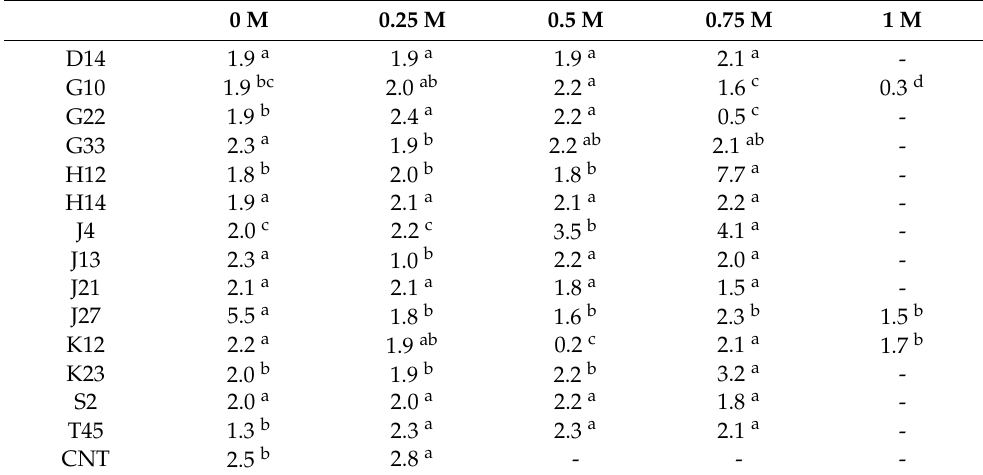
Table 4. Chlorophyll a/b ratio of inoculated and uninoculated plants without (0 M NaCl) and